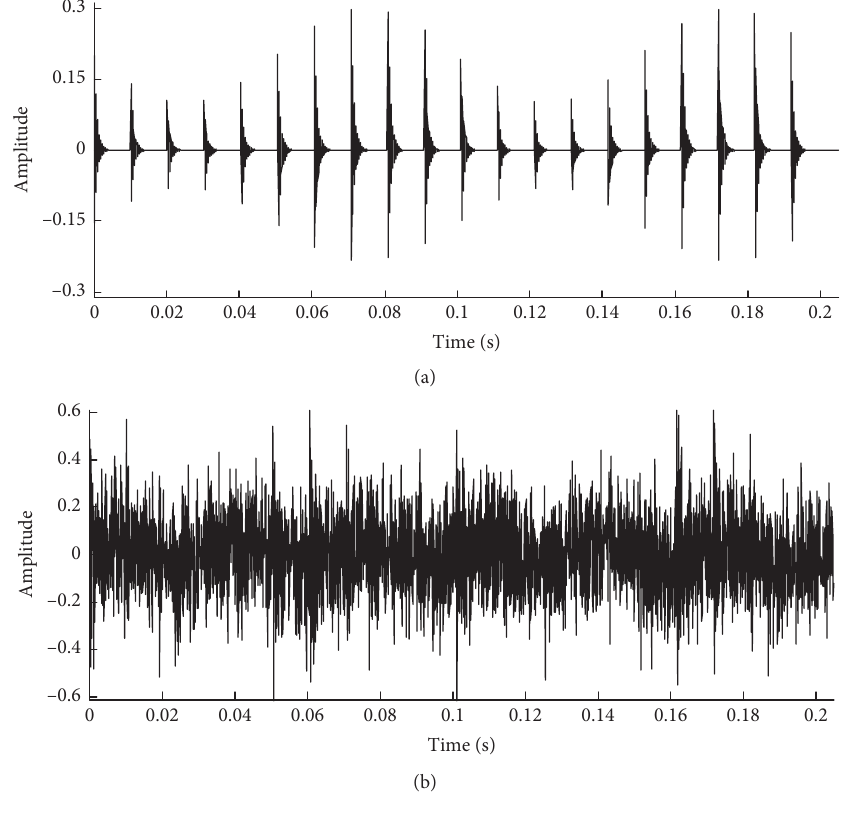
Figure 3: Periodic impact signal x